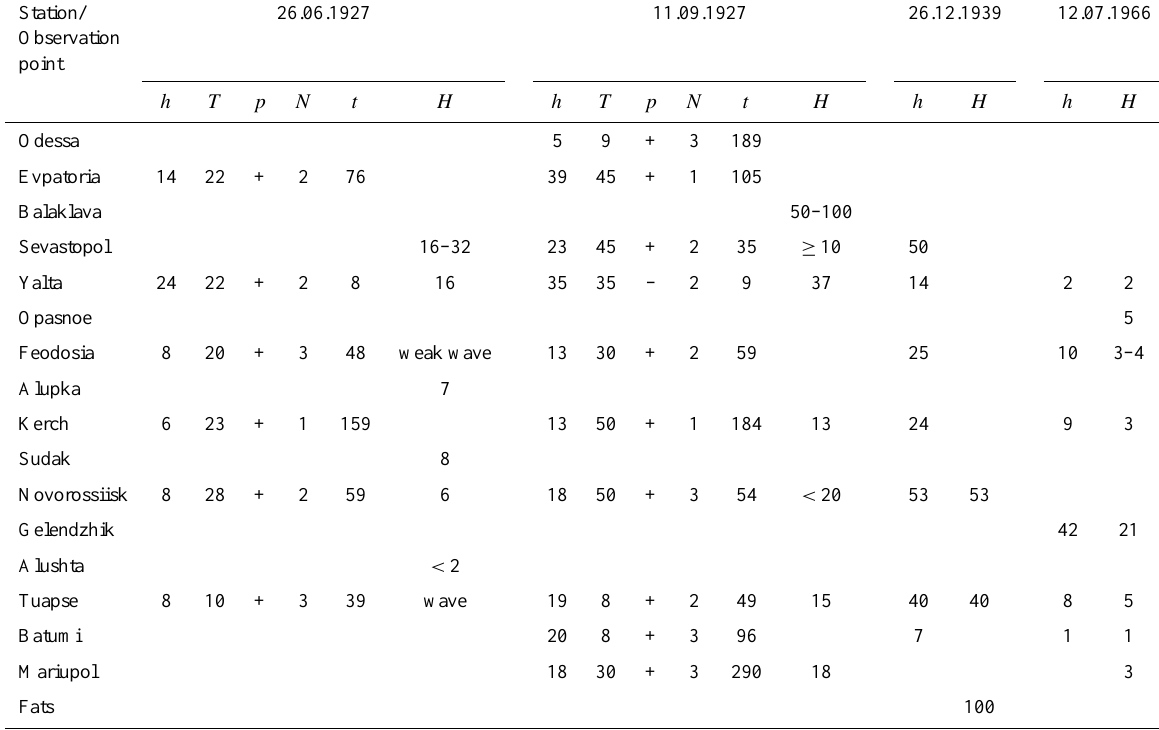
Table 2. Parameters of Black Sea tsunamis. Key: h =wave height (in cm), T =characteristic period of wave (in min), p =polarity of first wave motion in the station, N =number of the highest wave, t =time of wave propagation from the tsunami source to the station, all these parameters were recorded by Soviet tide-gauge stations and collected by Dotsenko (1995) and Dotsenko and Konovalov (1996) from several sources, including Grigorash (1959a, b, 1972), Grigorash and Korneva (1969, 1972a, b) and Fomicheva et al. (1991); H =wave height (in cm) summarized by Nikonov (1997a) from records of Soviet tide-gauge stations (Grigorash, 1972; Grigorash and Korneva, 1969, 1972b) and observations from a long number of other Russian sources. One may observe that in some instances the wave heights summarized by Nikonov (1997a) are not consistent with those summarized by Dotsenko (1995) and Dotsenko and Konovalov